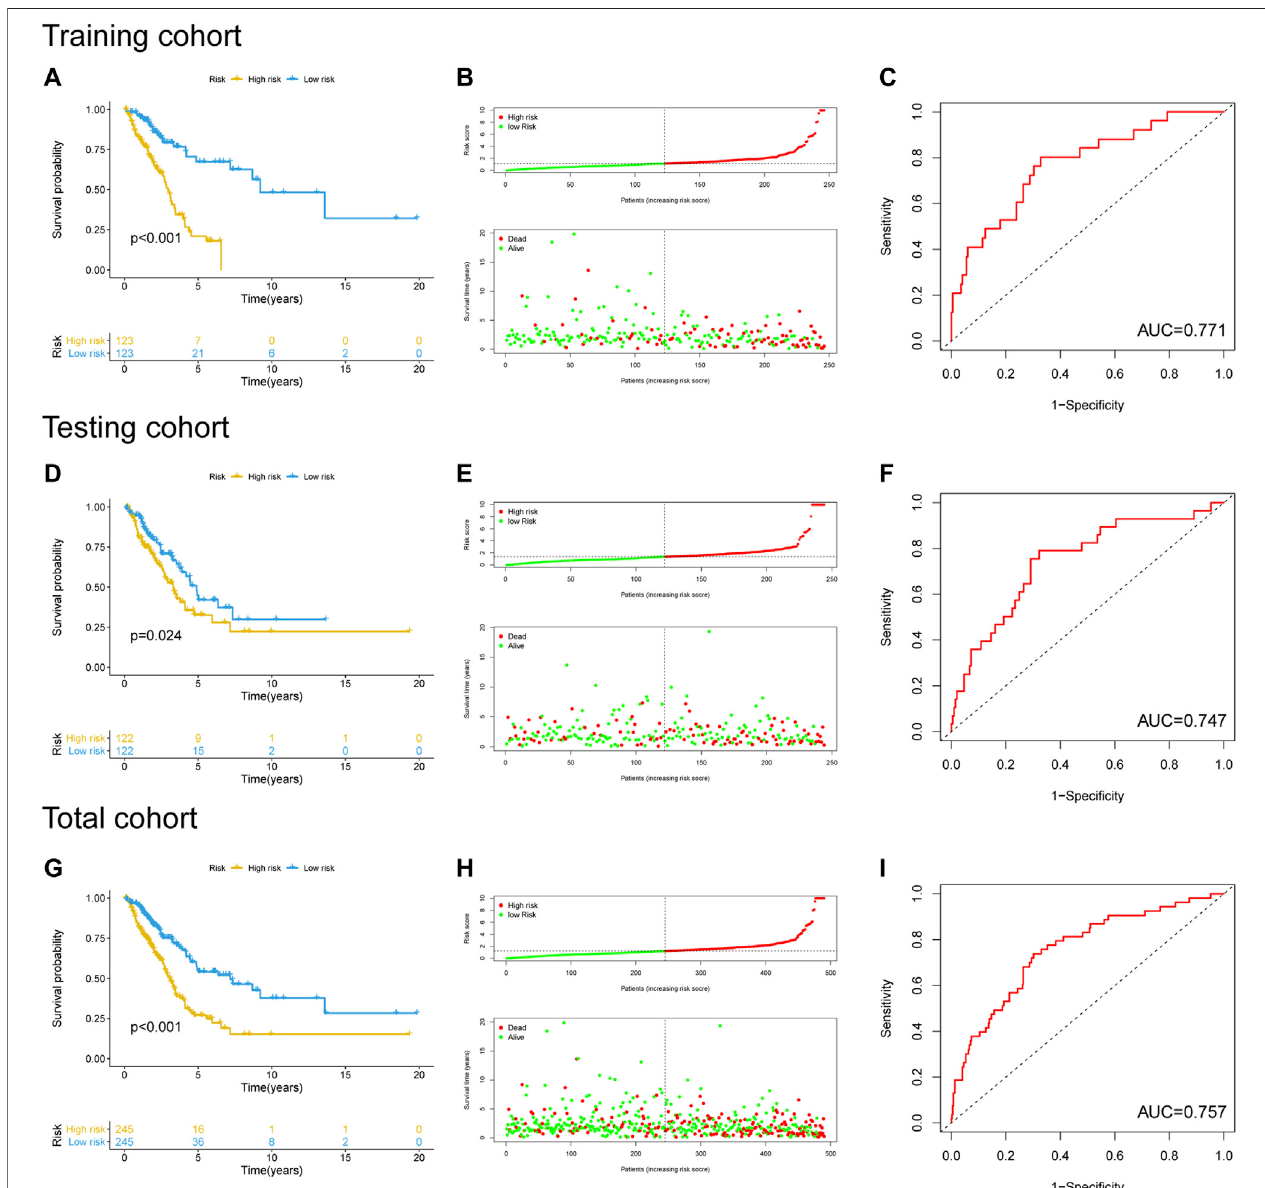
FIGURE 4 | Performance evaluation and validation of the newly developed GI-lncRNA-based model for the prediction of OS in LUAC patients. Kaplan – Meier analysisofOSbetweenthehigh-riskgroupandlow-riskgroupin (A) thetrainingcohort, (D) thetestingcohort,and (G) thetotalcohort;TherelationshipbetweenOSand risk-risk scores of the new prognostic model in the (B) the training cohort, (E) the testing cohort, and (H) the total cohort; The receiver operating curves for the new prognostic model in (C) the training cohort, (F) the testing cohort, and (I) the total cohort.